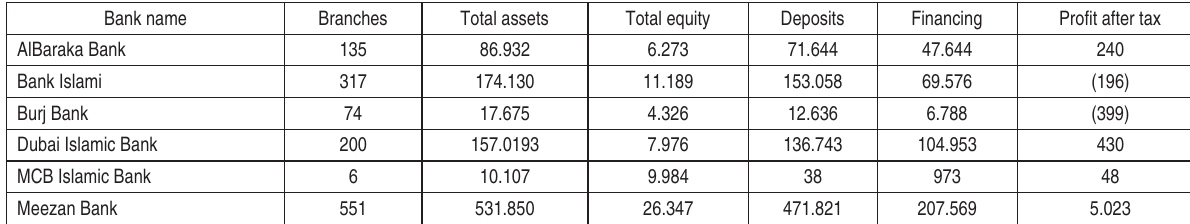
Table 3. Key values related to sample banks (all values in Million Rs except